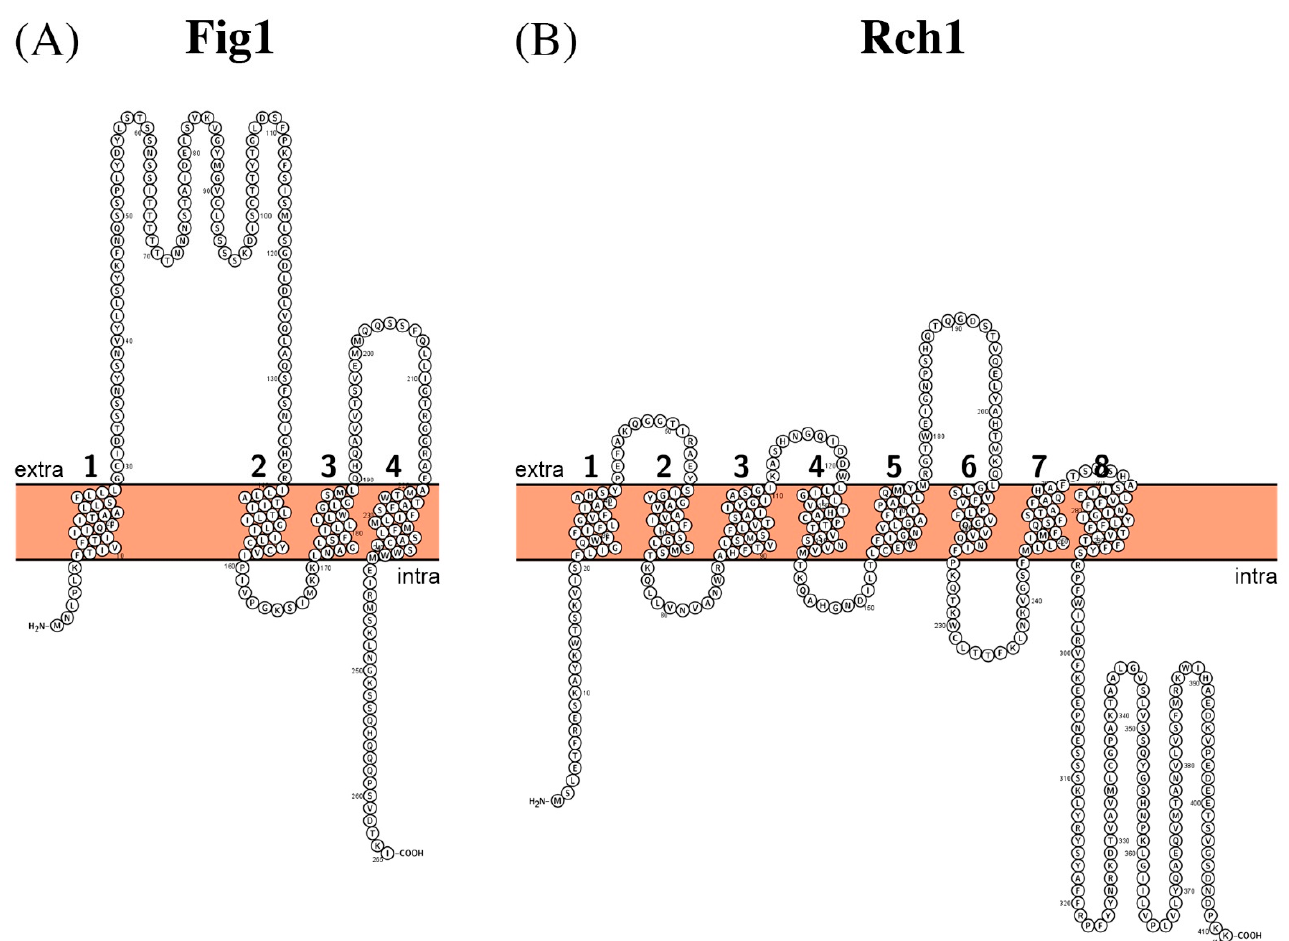
Figure 5. Schematic representation of the proposed secondary structure and topology of Fig1 ( A ) and Rch1 ( B ).